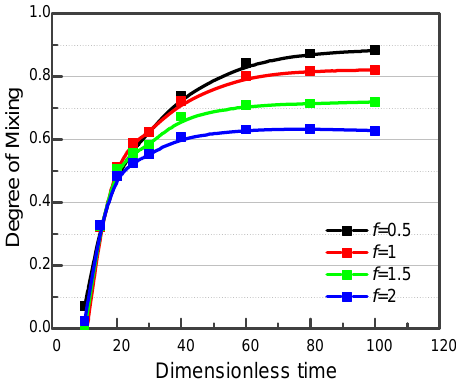
Figure 11. Degree of mixing in viscoelastic fluid case under modulated pressure at both inlets with different modulating frequencies.